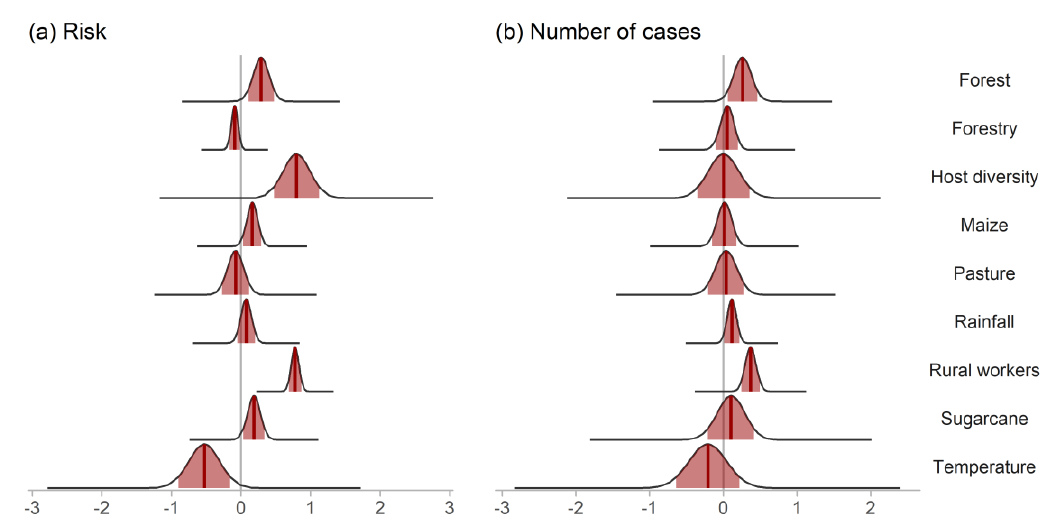
Figure 5. Posterior distributions of the effect sizes with the median (dark red line) and 95% credible intervals (light red shade) of each covariate on the ( a ) probability of cases and ( b ) positive counts of cases in a zero-truncated Poisson model, according to different predictors from two spatiotemporal models in Brazil from 2000–2014.